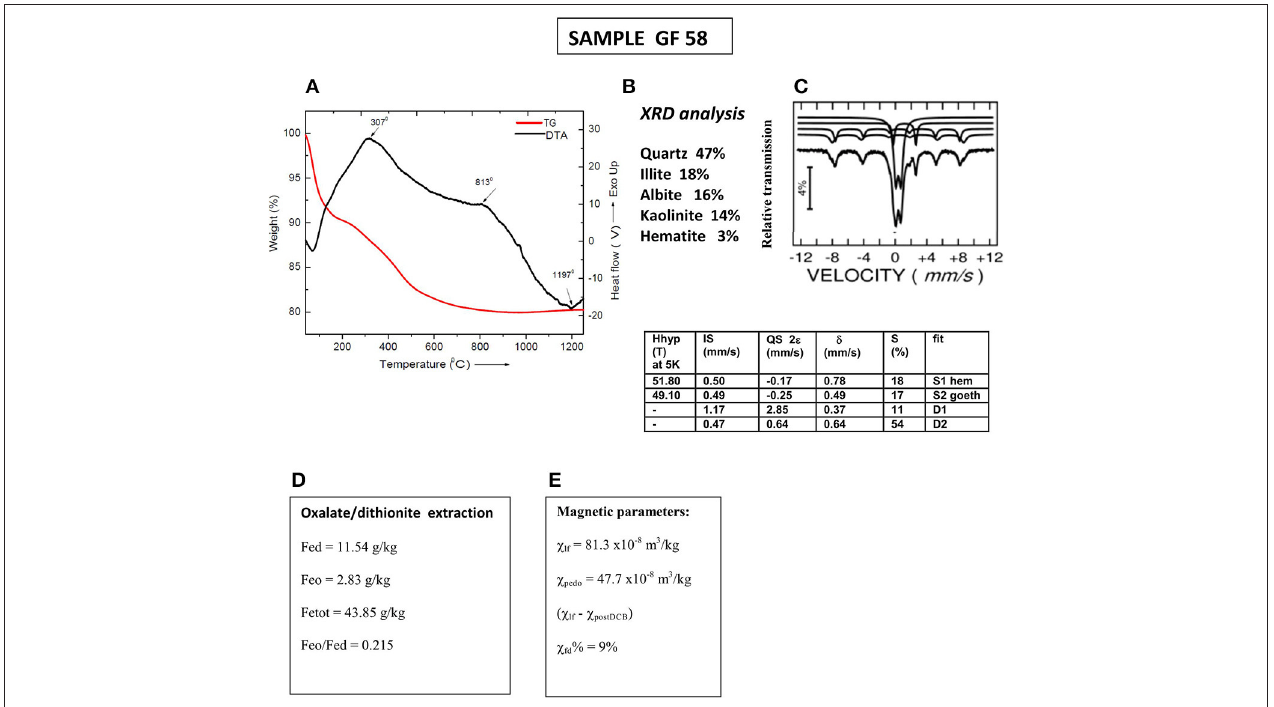
FIGURE 2 | Mineralogical and mineral magnetic characterization of sample GF58. (A) thermogravimetry (TG) and differential thermal analysis (DTA); (B) qualitative XRD analysis; (C) Moessbauer analysis at 5K with parameters listed in the Table: Hhyp, hyperfine field; IS, isomer shift; QS, quadrupole splitting; δ , hyperfine splitting; S%, relative area; (D) magnetic susceptibility data—bulk low-field susceptibility ( χ ), pedogenic susceptibility ( χ pedo ) obtained as a difference between initial and post-CBD signal and percent frequency dependent magnetic susceptibility χ fd%; (E) extractable Fe: Fed–dithionite extractable Fe; Feo–oxalate extractable Fe; Fe tot –total iron